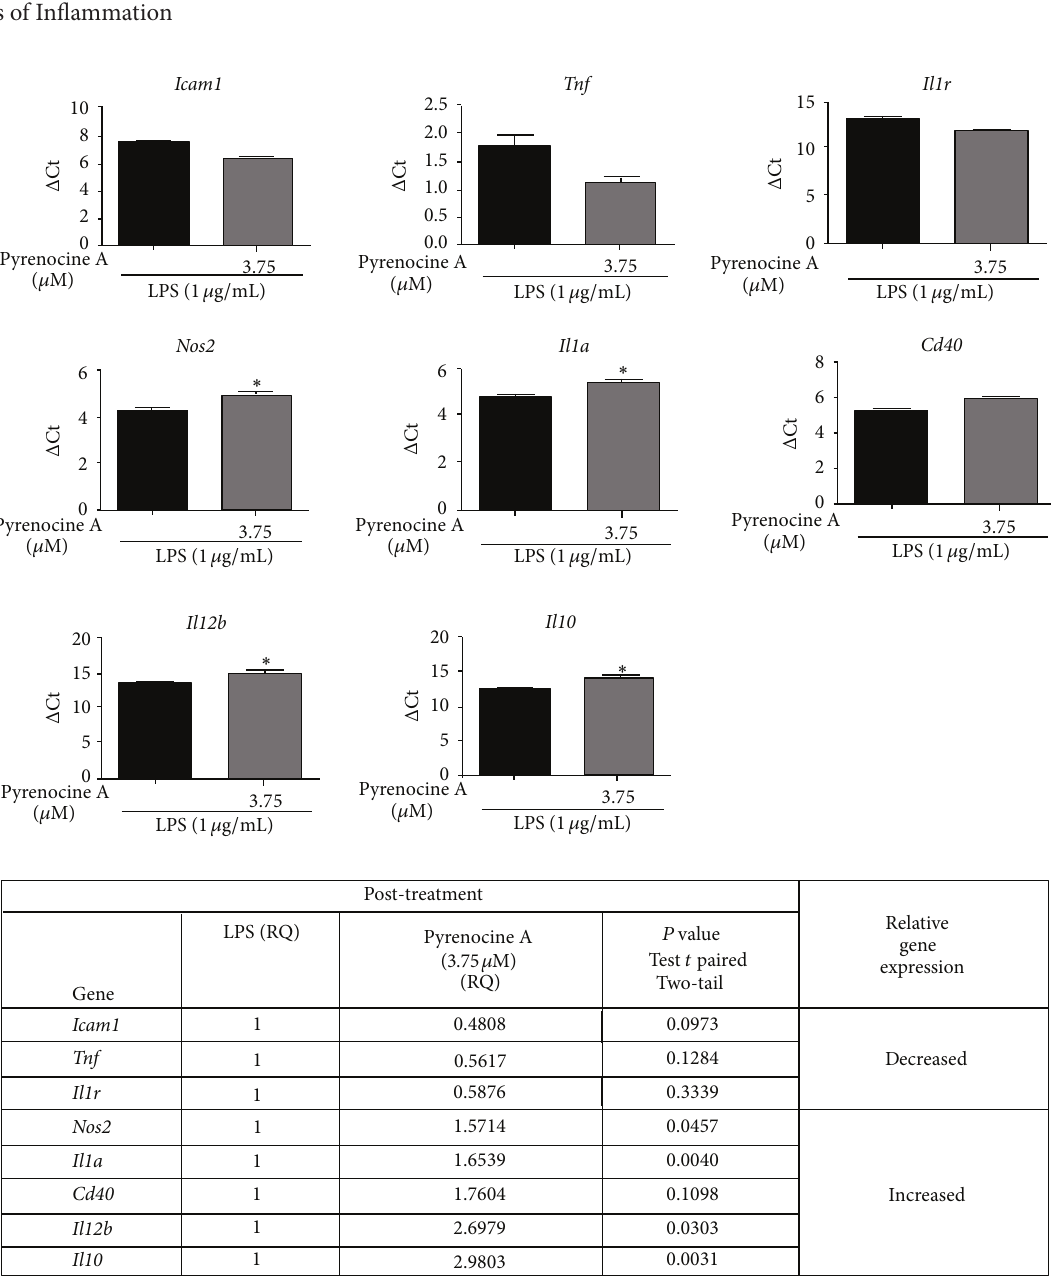
Figure 8: Evaluation of expression of genes related to NF 𝜅 B-mediated transcription-PostTreatment procedure. Cells were stimulated with LPS (1 𝜇 g/mL) for 2h and then pyrenocine A was added (3.75 𝜇 M) during 18h. PCR array plates were purchased from Life Technologies. The results are presented as log Δ Ct to statistical analysis (Test 𝑡 ∗ 𝑃 < 0.05 ) and RQ (relative quantification) to show the variation in gene expression (less than 0.6 was considered decreased and more than 1.4 increased). The results show the mean and standard deviation of 3 independent experiments. ∗ 𝑃 < 0.05